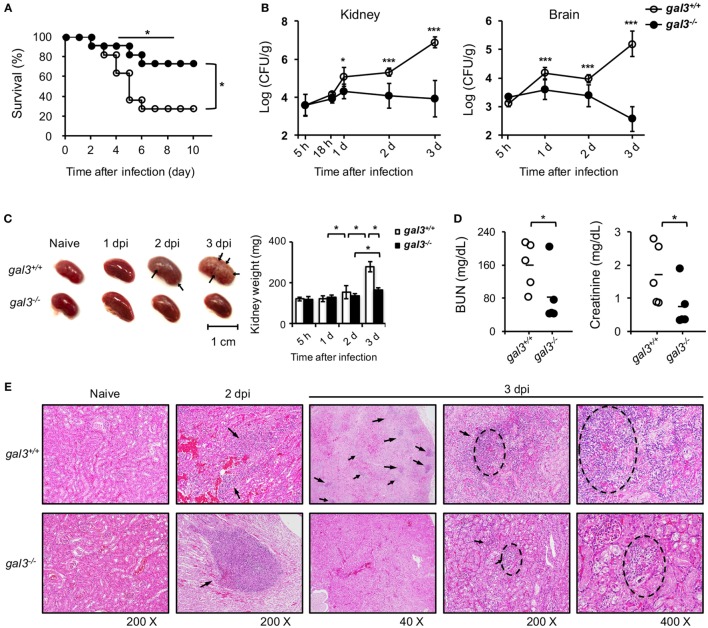
Gal3 deficiency ameliorates Candida infection. Gal3+/+ and gal3−/− mice were infected intravenously with 5 × 105 of Candida. Kidneys were collected from uninfected (naïve) and infected mice at different time points after infection (dpi). (A) The survival of infected mice was followed until day 10 after infection. n = 11. Data are pooled from three independent experiments. *p < 0.05, as analyzed by log-rank and Fisher’s exact test. (B) Fungal burden in the kidney is shown as Log10 CFU per gram of tissue. n = 6. Data are pooled from two independent experiments and presented as mean ± SD. (C) Kidneys were collected from uninfected and infected mice on different days after infection (dpi). Left, arrows point to abscess lesions; right, kidney weight. n = 6. Data are pooled from two independent experiments and presented as mean ± SD. (D) The levels of blood urea nitrogen and creatinine in mouse sera on day 2 after infection. n = 5. Data are pooled from two independent experiments. *p < 0.05; ***p < 0.005, as analyzed by Mann–Whitney test. (E) Kidneys were collected and fixed in formalin before H&E stain. The magnification is 200× for sections from naïve mice and mice at day 2 after infection and 40×, 200×, and 400× for sections from mice at day 3 after infection. Arrows point to inflammatory foci. n = 3. See also Figures S2 and S3 in Supplementary Material.